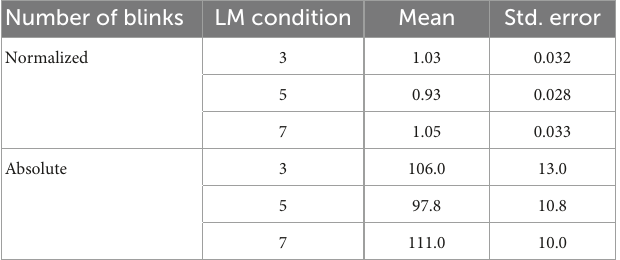
TABLE 1 Means and standard errors of the normalized and absolute number of blinks for each landmark